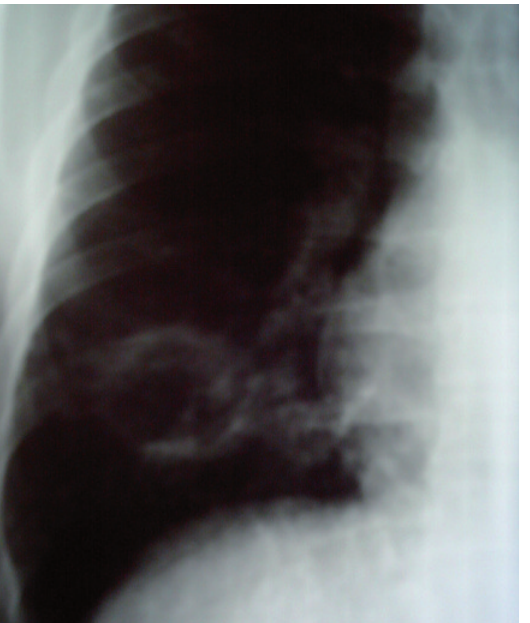
Cavernous lesion in the lower lobe of the right lung.